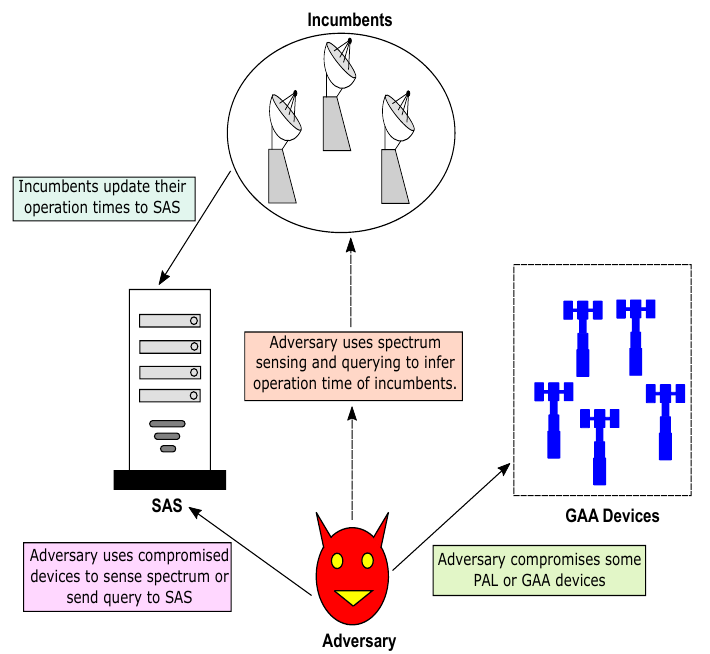
Figure 8. Adversary infers the operation time of the